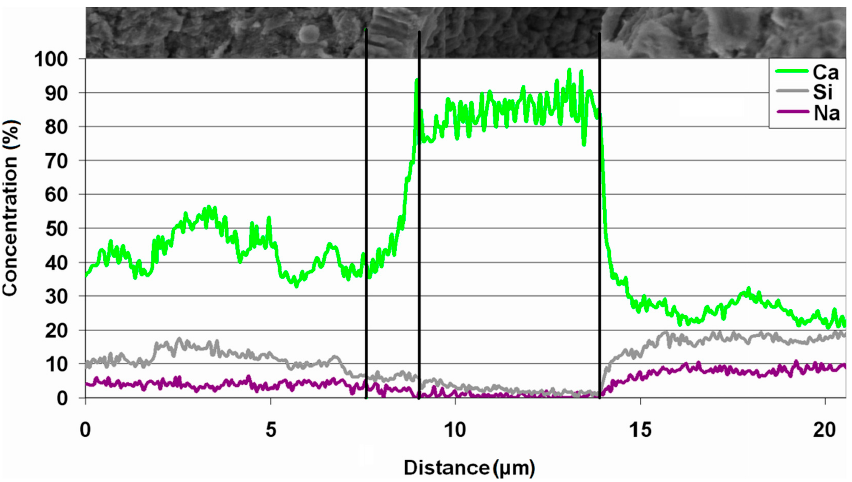
Figure 9. Changes of elements concentrations between carbonate cement and spherical silicon agglomeration from Figure 8a.